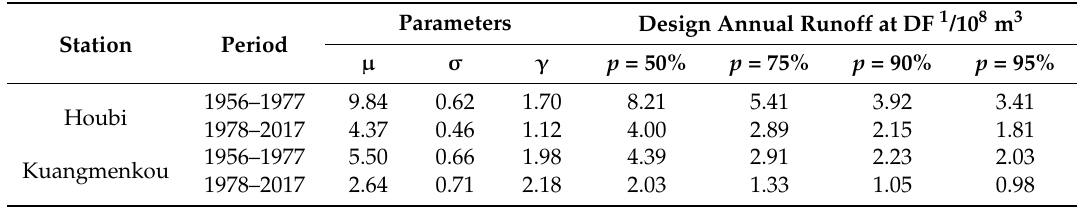
Table 4. The hydrological frequency analysis results of annual runoff subseries at two sections.